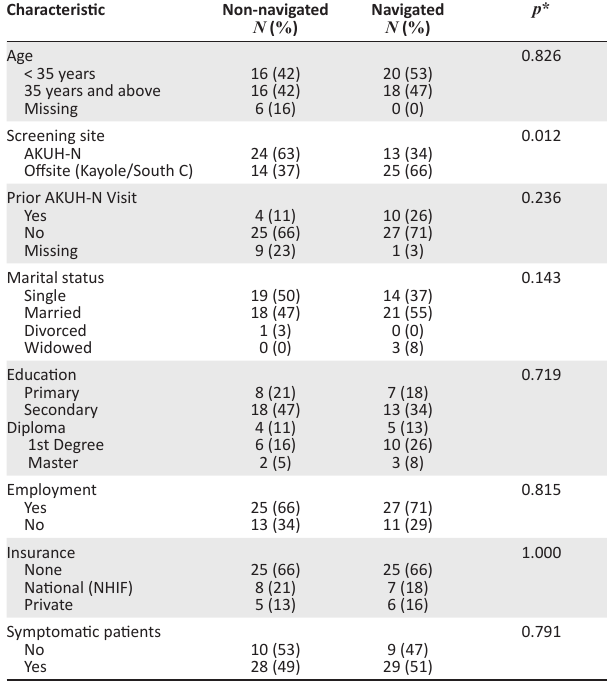
TABLE 1: Baseline characteristics of patients with positive breast examination finding in the non-navigated and navigated group. Characteristic